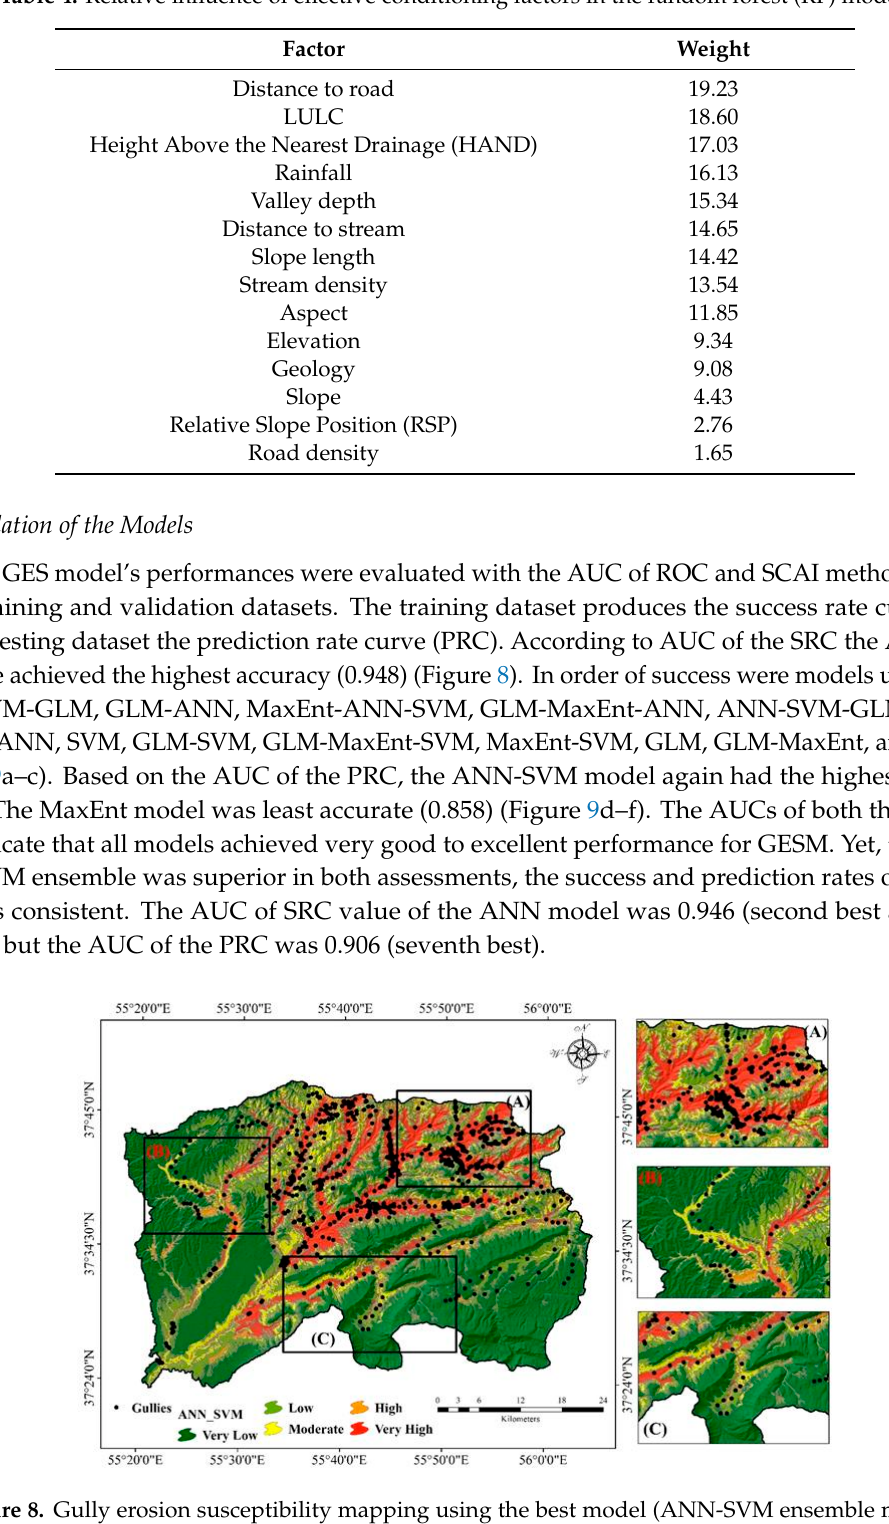
Table 4. Relative influence of effective conditioning factors in the random forest (RF) model.